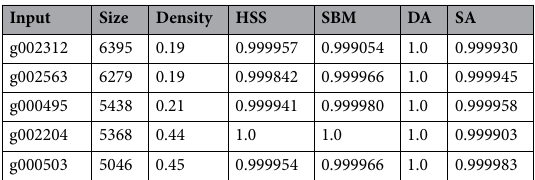
Table 8. Results for large and medium classes, same as Table 1.